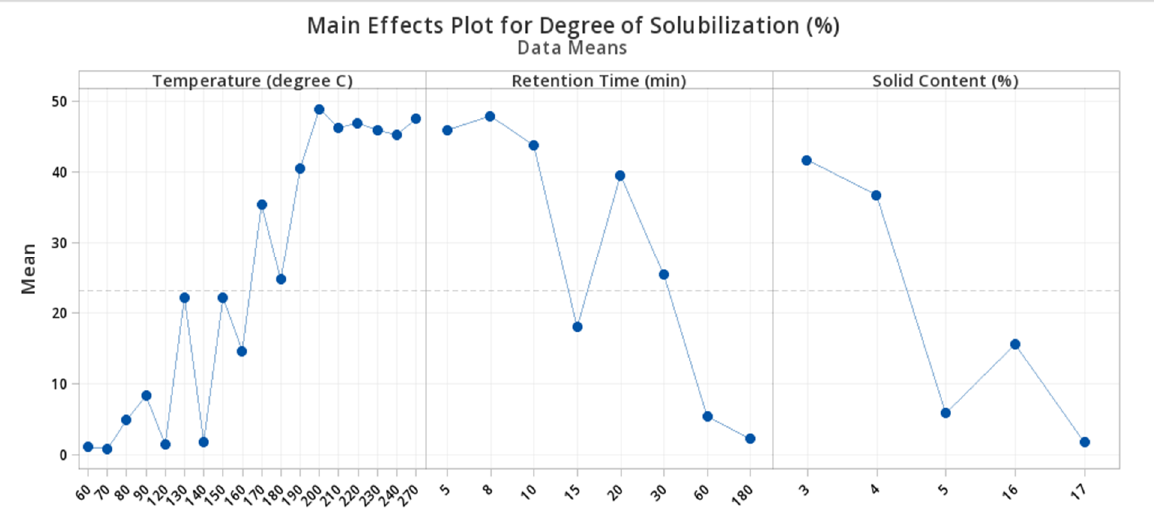
Figure 1. Main effect plot for the degree of solubilization after HTP vs. temperature, retention time, and solid content. Table 1. Studies on hydrothermal pretreatment of TWAS for VFAs recovery.